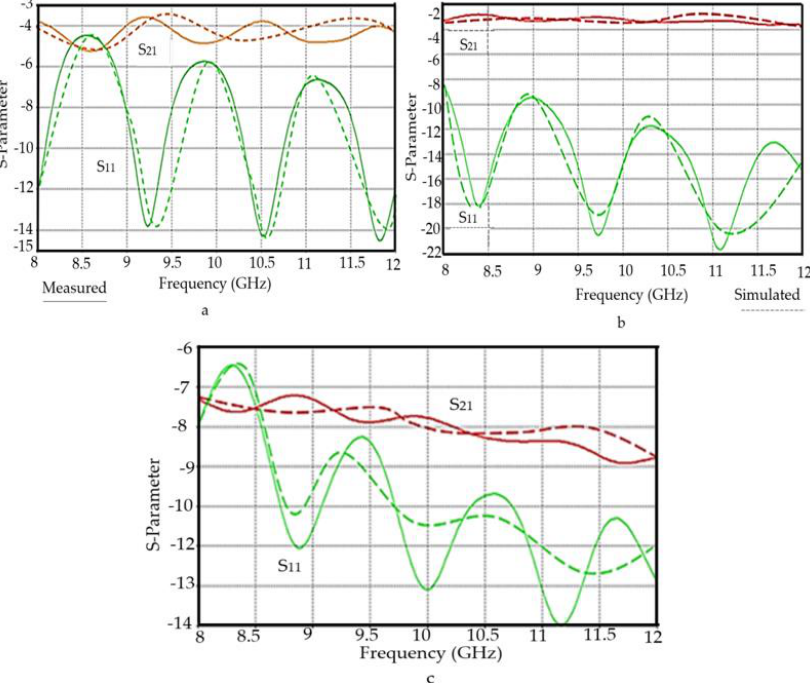
Figure 10. The S-parameters of the substrates ( a ) OPEFF/PCL, ( b ) NiO/PCL, and ( c ) OPEFF/NiO/PCL obtained by rectangular waveguide connected to VNA.